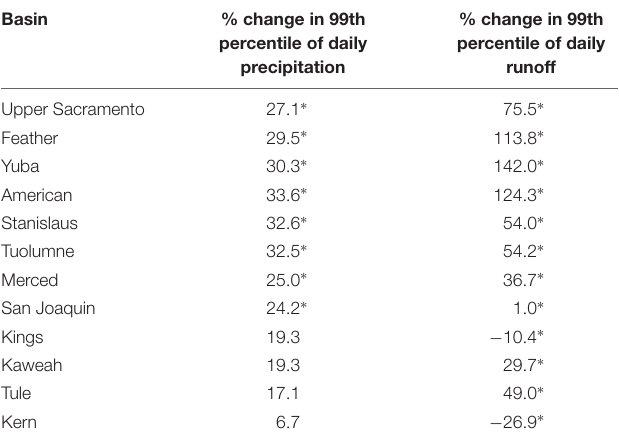
TABLE 3 | Percent change by end-century in daily precipitation and runoff percentiles for Sierra Nevada basins.